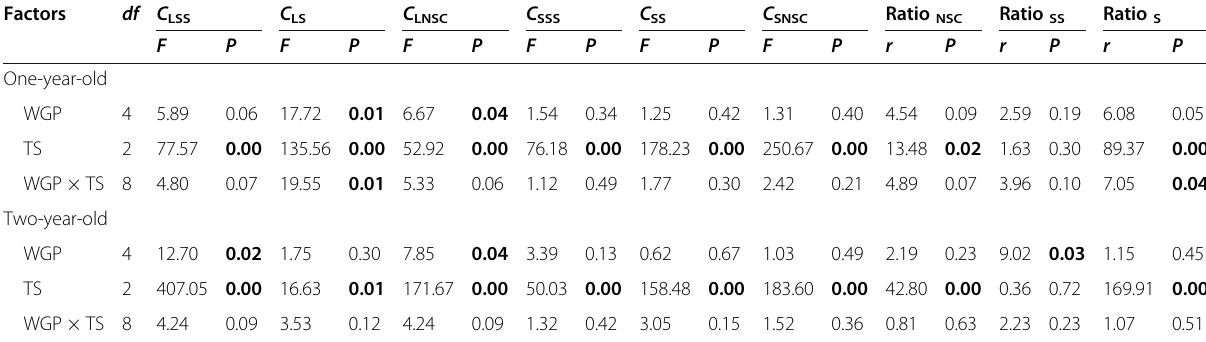
Table 5 Effects of within-gap position and tree species on the concentrations of NSCs (soluble sugar, starch, and total NSC) and the ratios of leaf NSCs to stem NSCs in 1-year-old sprouts and 2-year-old sprouts Factors df C LSS